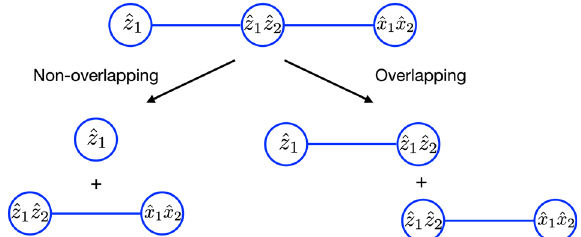
Fig. 1 Illustration of non-overlapping and overlapping partition- ing. The graph is based on full commutativity for a model Hamiltonian,